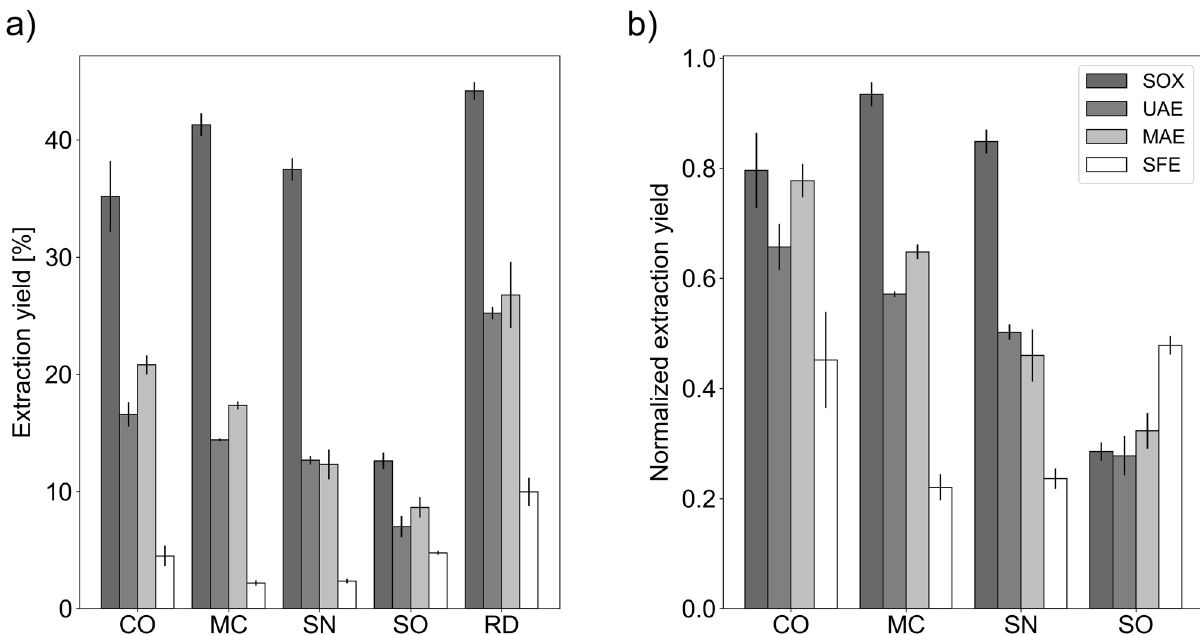
Figure 1. Yields of extracts prepared using different methodologies, given as ( a ) percent of dry plant material used and ( b ) fraction of extraction efficiency obtained for damask rose petals, when using the same extraction conditions. Error bars represent one standard deviation (extractions performed in